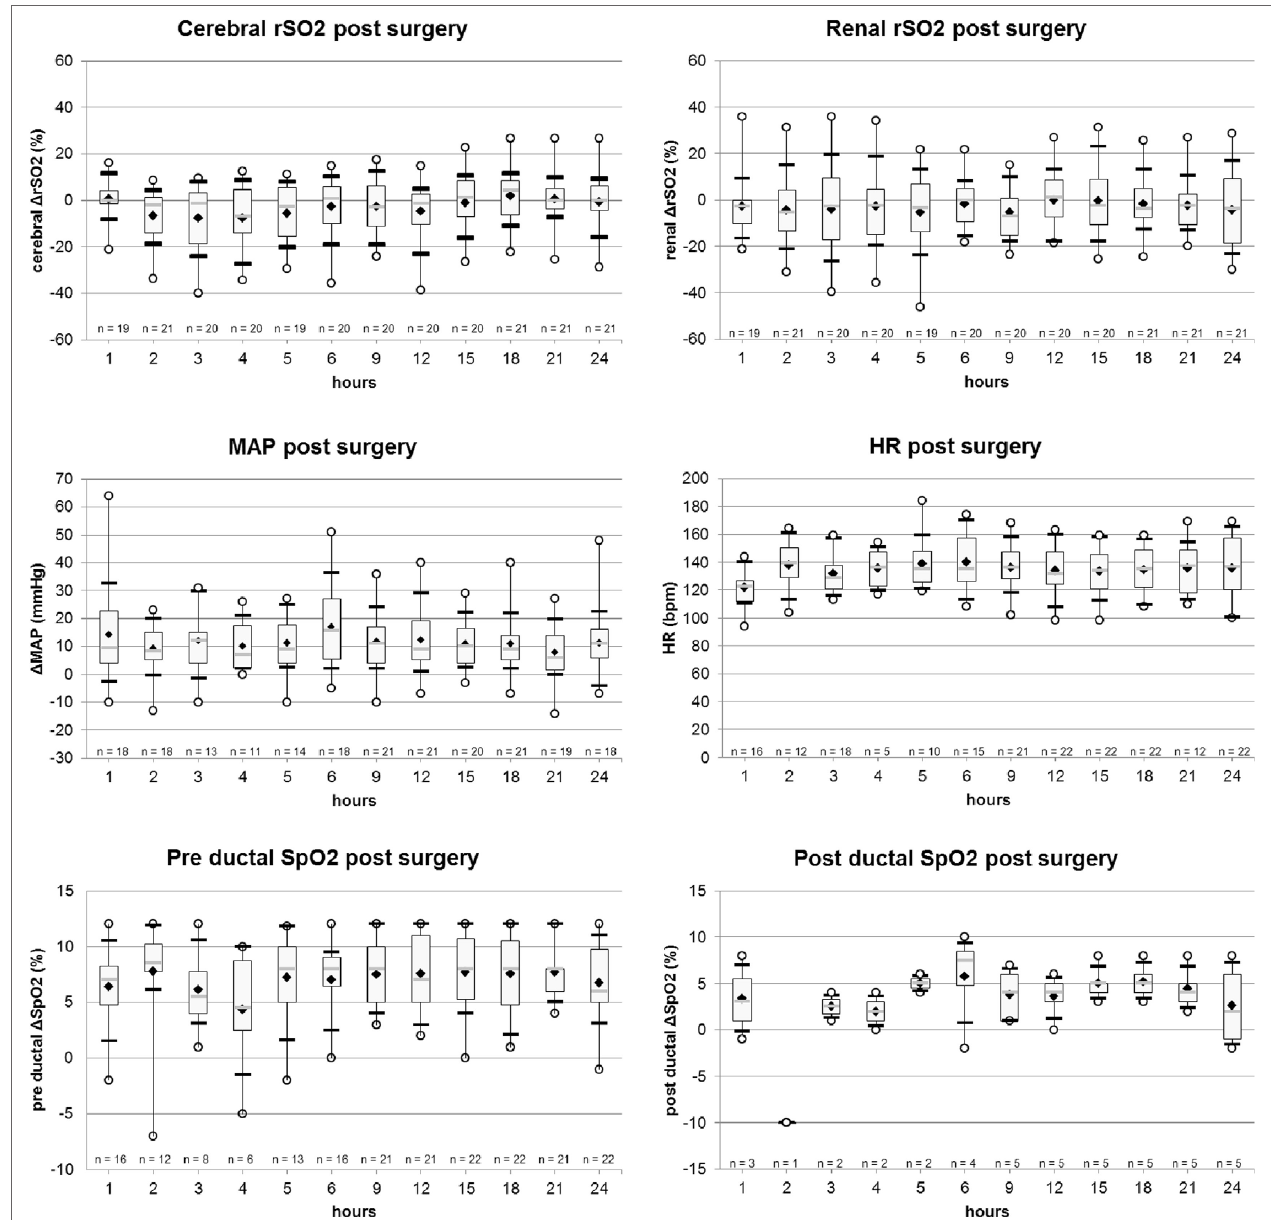
FigUre 2 | Evolution of cerebral and renal rSO 2 (%), mean arterial pressure (MAP) (mmHg), heart rate (HR) (bpm), pre and post ductal SpO 2 values, from H1 to H6 post-surgery. Legend: ⚪ , minimum and maximum; — , first and ninth decile; gray — , median; white ▮ , quartile 25 and quartile 75; ⧫ ,